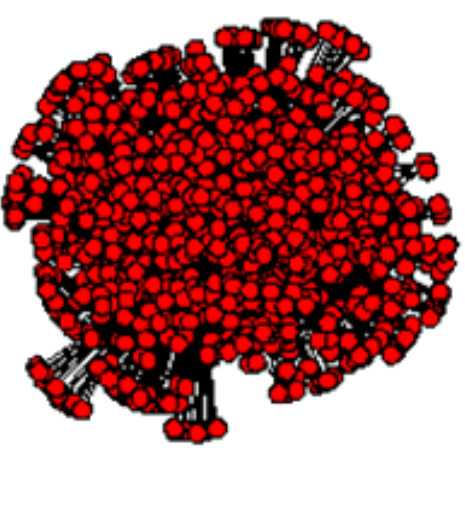
Figure 1. Informational support